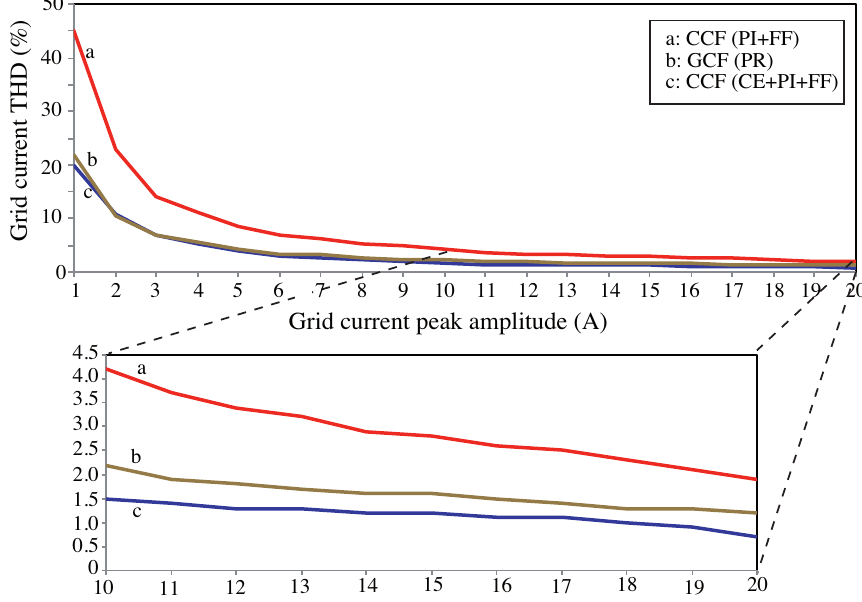
Figure 15. Grid current THD for CCF (with and without the CE technique) and the GCF strategy with a PR